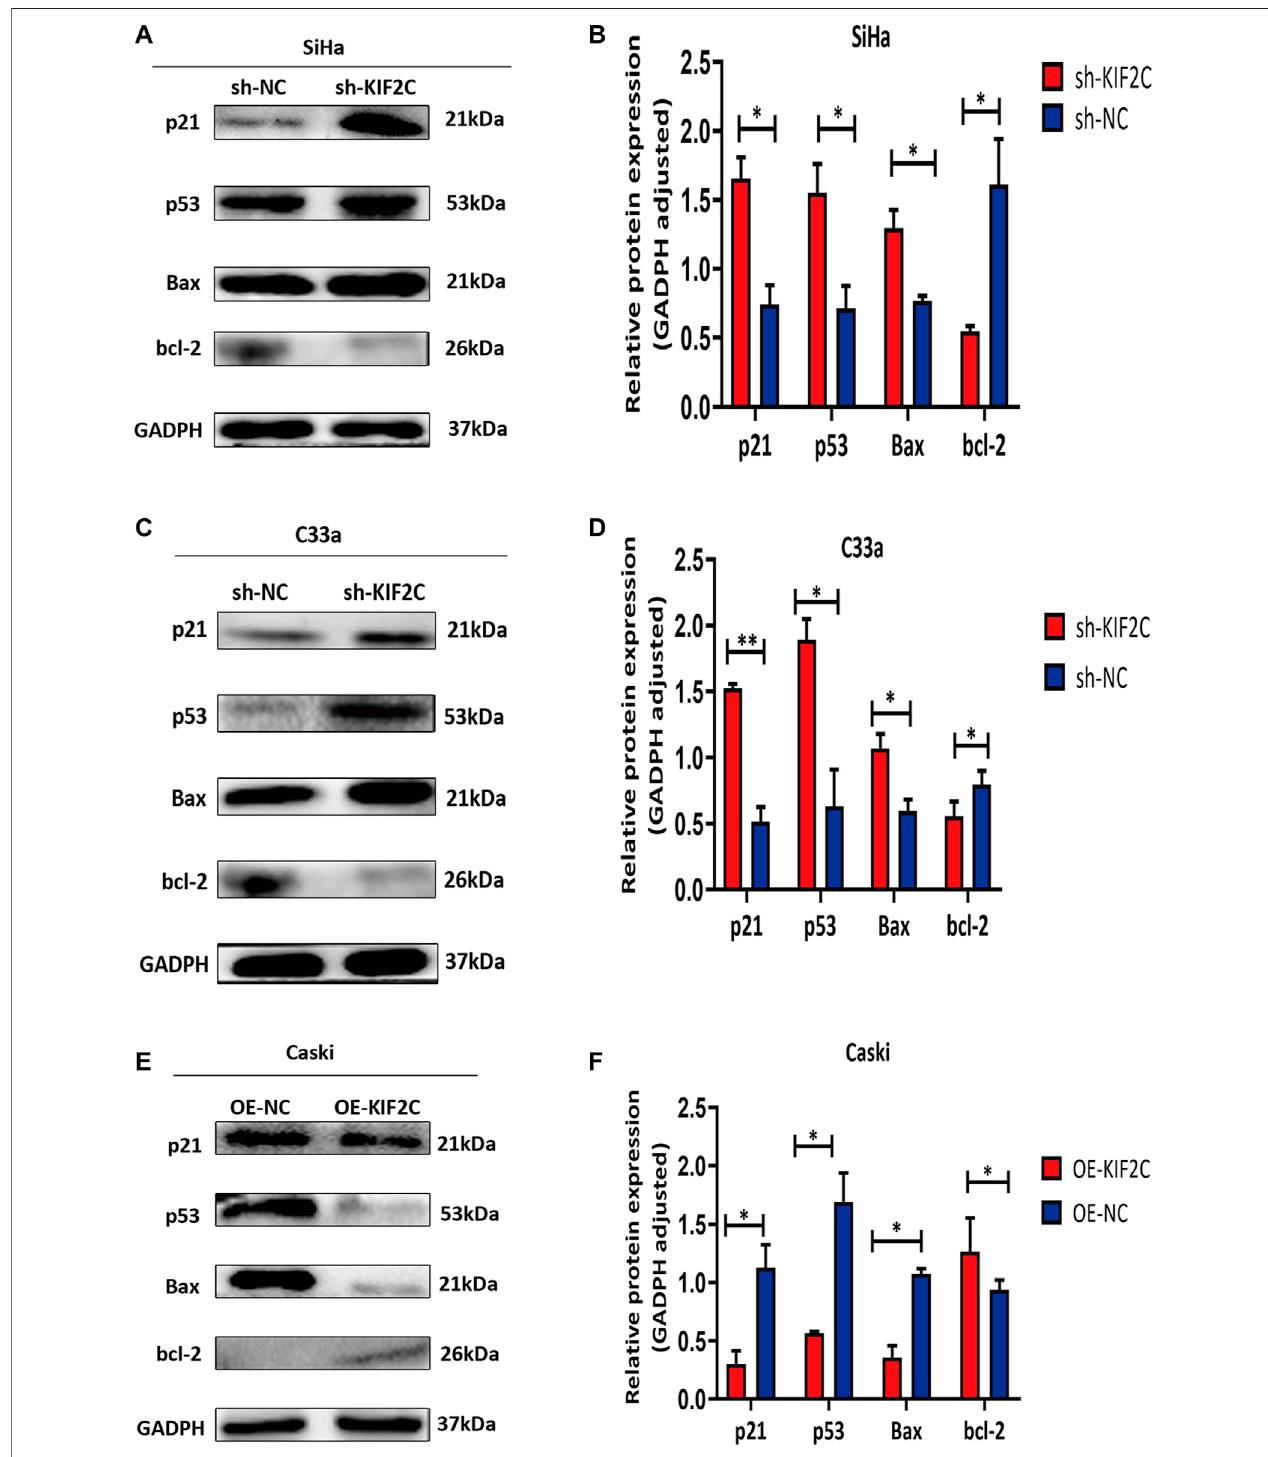
FIGURE 10 | KIF2C knockdown promoted activation of p53 signaling pathway. Relative protein expression levels of p21, p53, and Bax were signi fi cantly increased, whereas those of bcl-2 was signi fi cantly decreased in SiHa (A,B) and C33a (C,D) cells with KIF2 knockdown. However, expression of proteins mentioned earlier exhibited an opposite trend in presence of KIF2C overexpression (E,F) . *p < 0.05, ** p < 0.01.